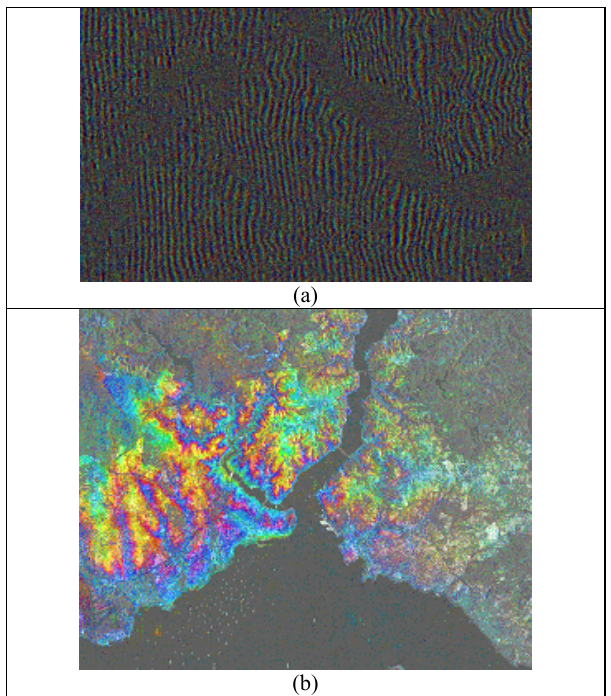
Figure 5. Interferograms of TSX HS and SM image-pair Coherence and Interferogram Filtering